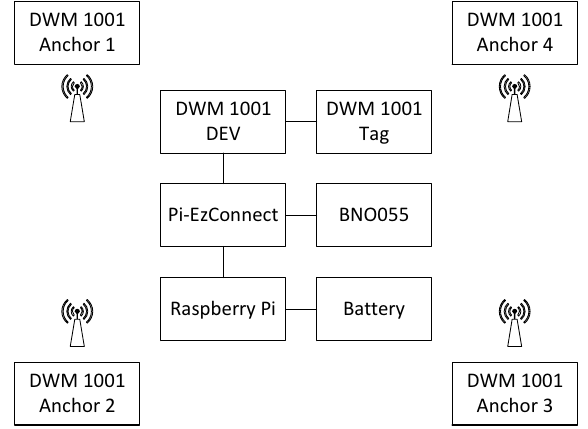
Figure 2. System design of the UWB and IMU tracking system.